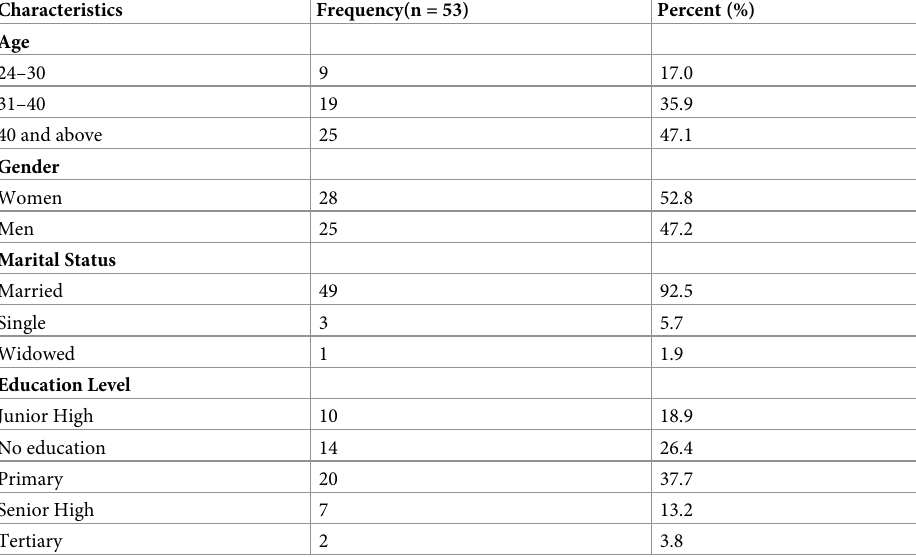
Table 2. Socio-demographic characteristics of the study